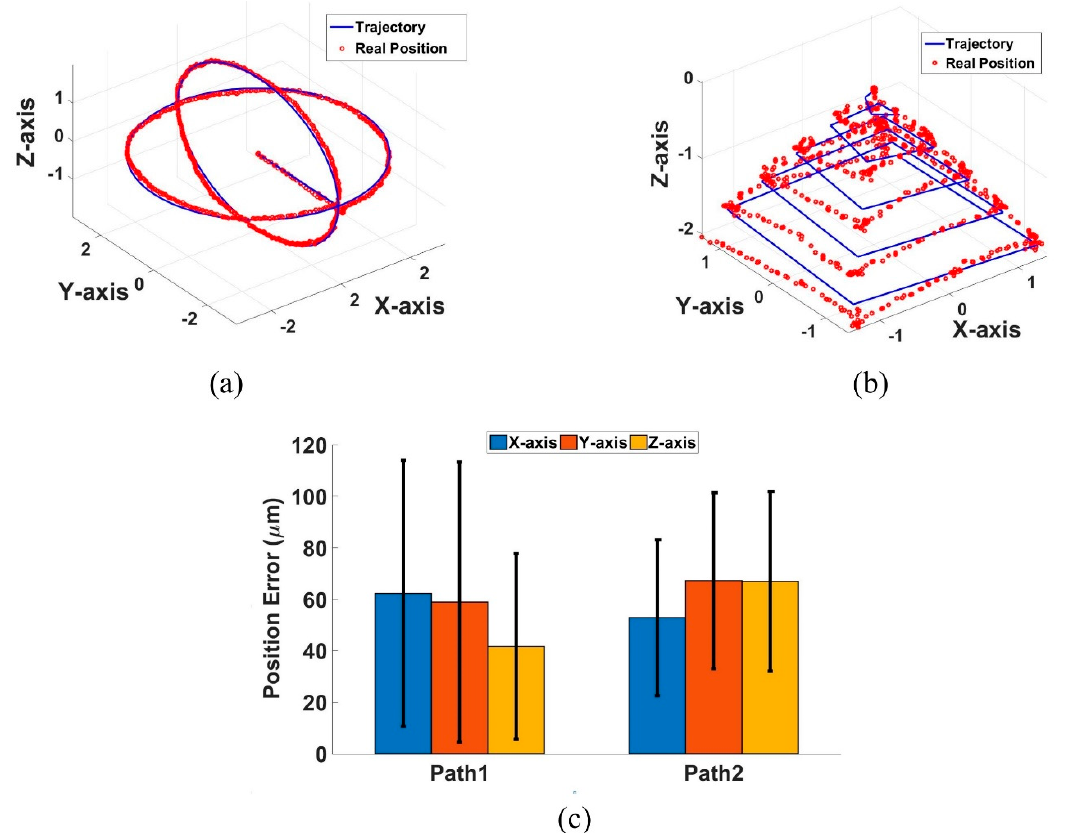
Figure 9. Demonstration of 3D automated close ‐ loop control: ( a ) Trajectory with a globular shape— path 1; ( b ) Trajectory with a pyramid shape—path 2 keeping its orientation constant along the X ‐ axis. The way points (red •) are data tracked by the vision system. The green line (( ‐ ) is the pre ‐ programmed trajectory for reference; ( c ) Root mean square and standard deviation of position error in the ‐ X , ‐ Y , ‐ Z axis in path 1 and path 2.